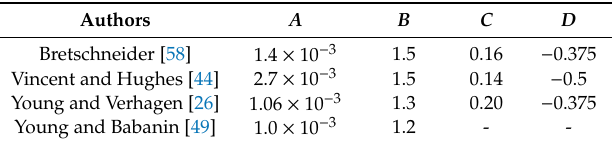
Table 1. Constant values of the coe ffi cients entering in the limit Equations (4) and (5), according to di ff erent